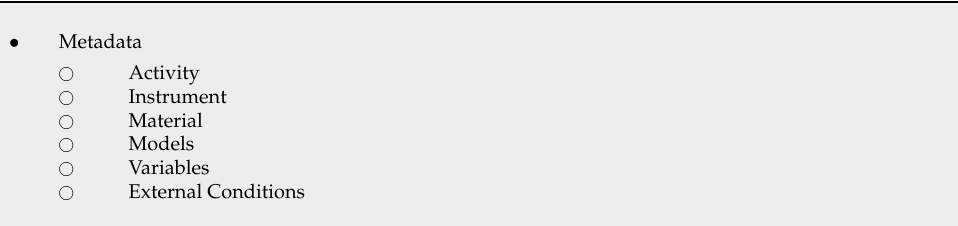
Table 17. Hierarchy of top-level metadata.